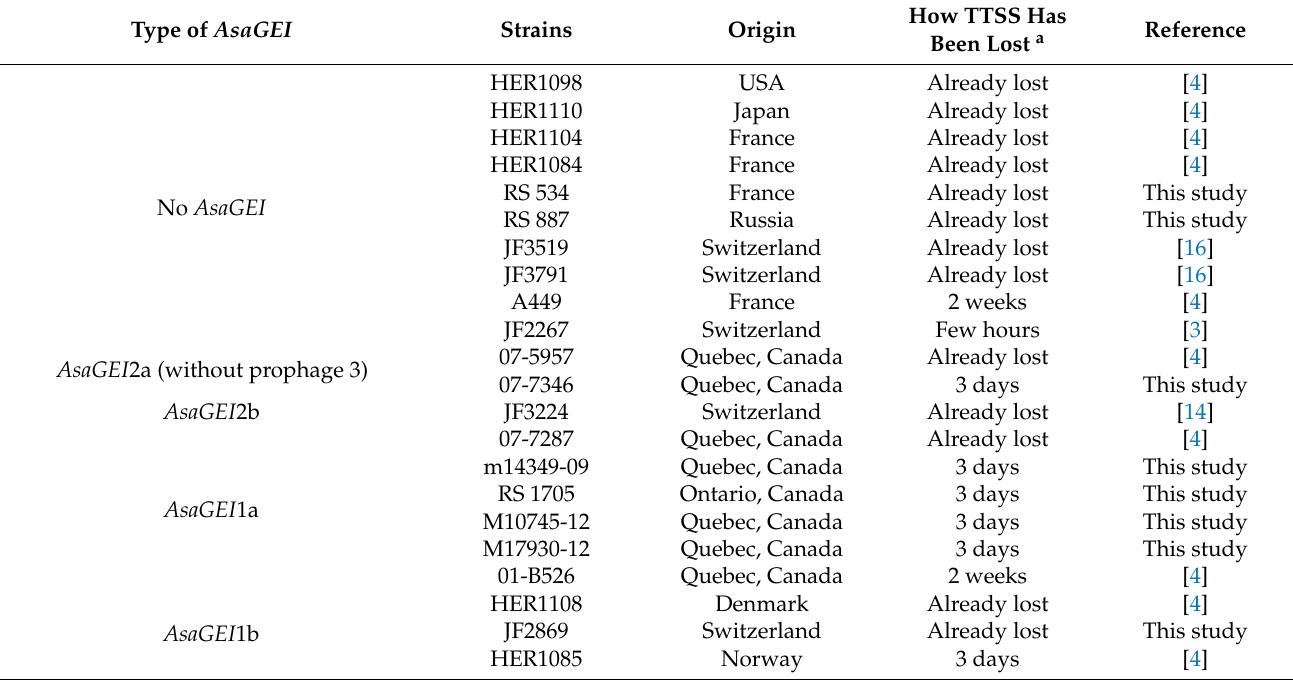
Table 1. Strains of A. salmonicida subsp. salmonicida which have already lost the genes encoding TTSS before their inclusion in our strain collection or which have lost it in the laboratory following incubation at 25 ◦